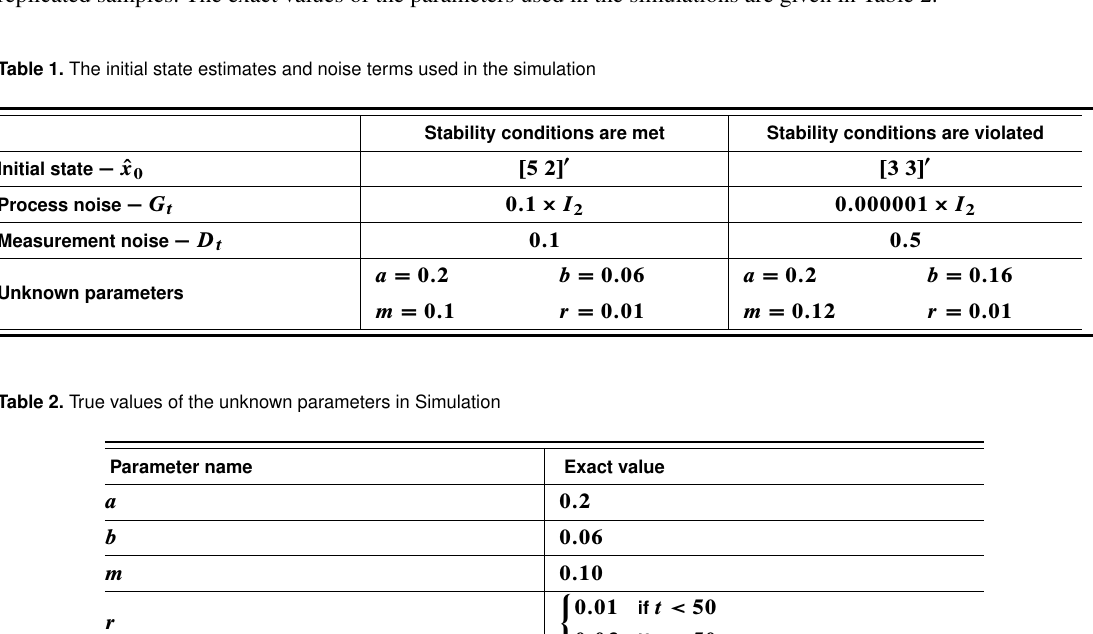
Table 1. The initial state estimates and noise terms used in the simulation